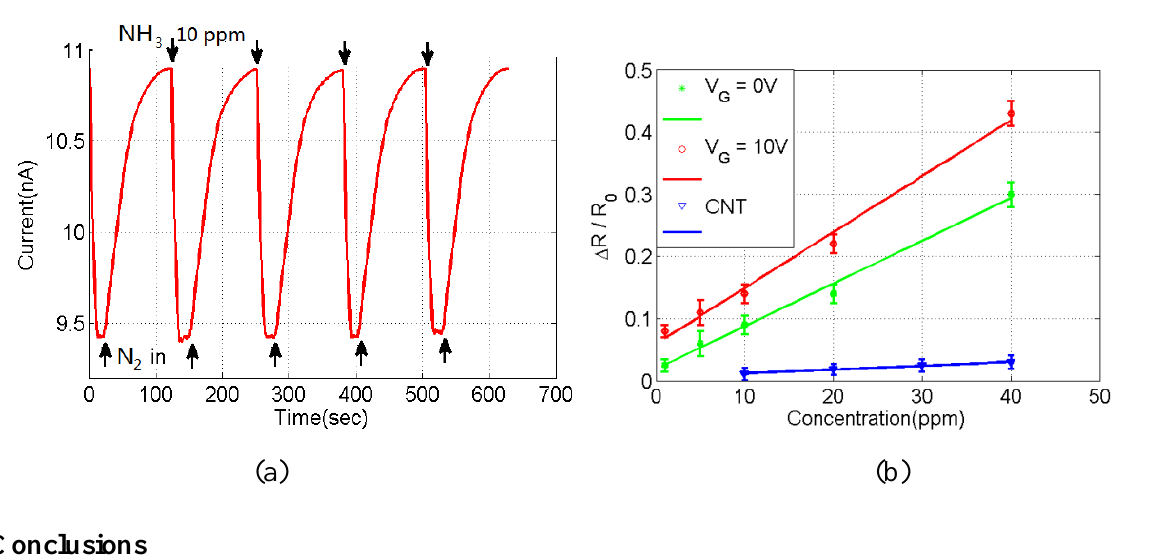
(V = −10 V). ( b ) Sensitivity compare of 3 G